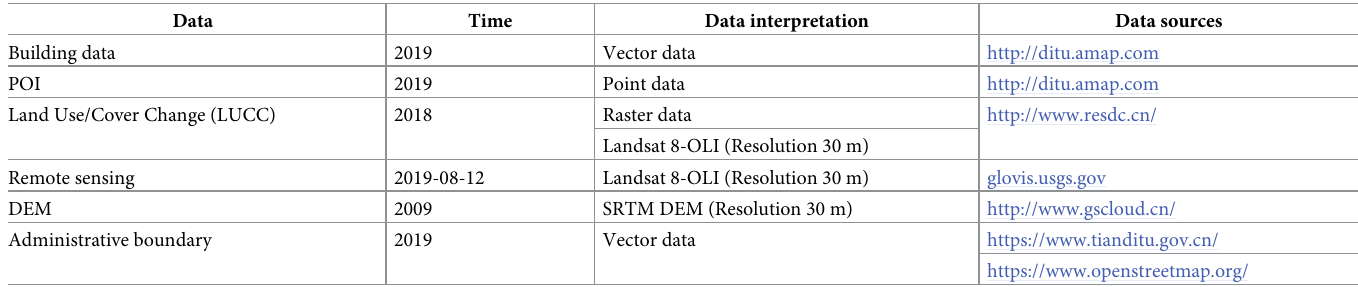
Table 1. Data source and